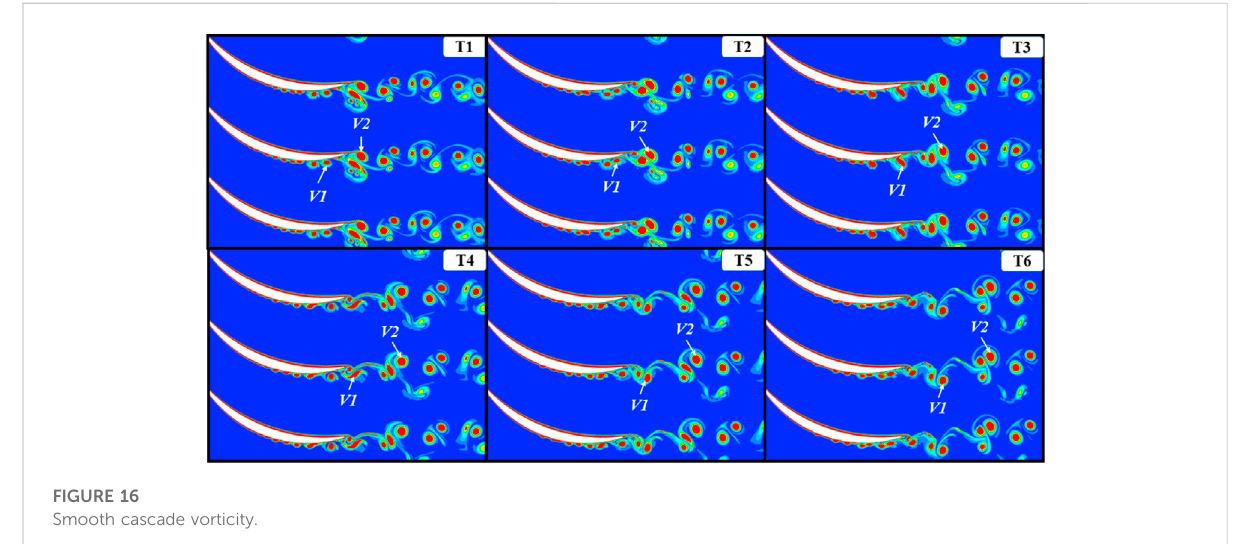
FIGURE 16 Smooth cascade